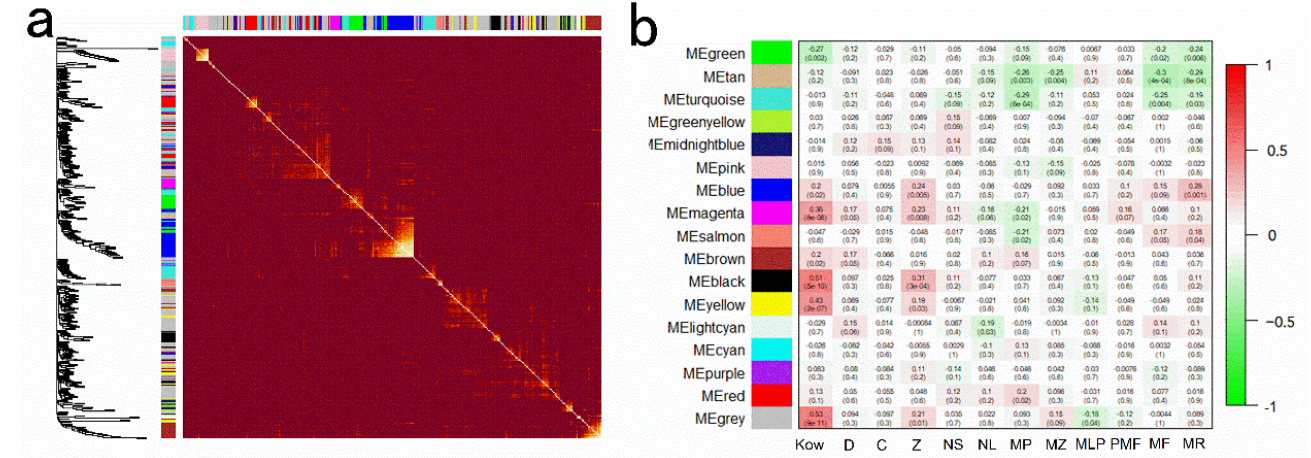
Figure 5. Weighted gene co-expression network analysis. ( a ) Cluster dendrogram of gene; each line represents one gene. ( b ) Module – trait relationships. The correlation coefficients and P values were exhibited in each cell.